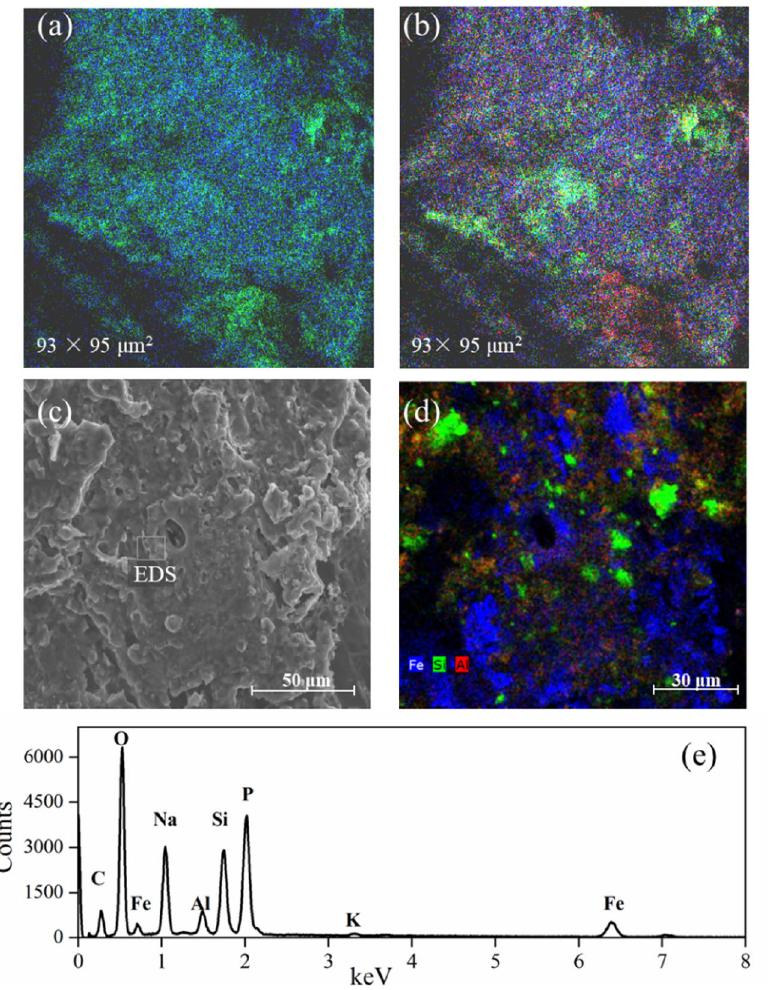
Figure 3. The morphology and elemental distribution at the exterior surface of the biochar-treated rice root. ToF-SIMS images of ( a ) the sum of CN − and CNO − (green) and Fe-bearing ions (Fe + , FeH + , FeOH + , FeO − , FeOH − , FeO 2 − , FeO 2 H − , FeO 3 − , FeO 3 H − ) (blue); and ( b ) the sum of Fe-bearing ions (blue), Al-bearing ions (Al + , AlH + , AlO − , AlO 2 − , Al 3 H 2 − , Al 3 H 2 O − ) (red) and Si-bearing ions (Si + , SiHO + , SiO 2 − , SiHO 3 − , Si − , SiHO 2 − , SiO 3 − ) (green). ( c ) SEM secondary electron image of the exterior surface of the root and ( d ) EDS mapping showing the elemental distribution of Fe, Al, and Si, and ( e ) EDS spectrum obtained from the region of interest in Fig. 4c, showing strong signals from P, Si, Al and